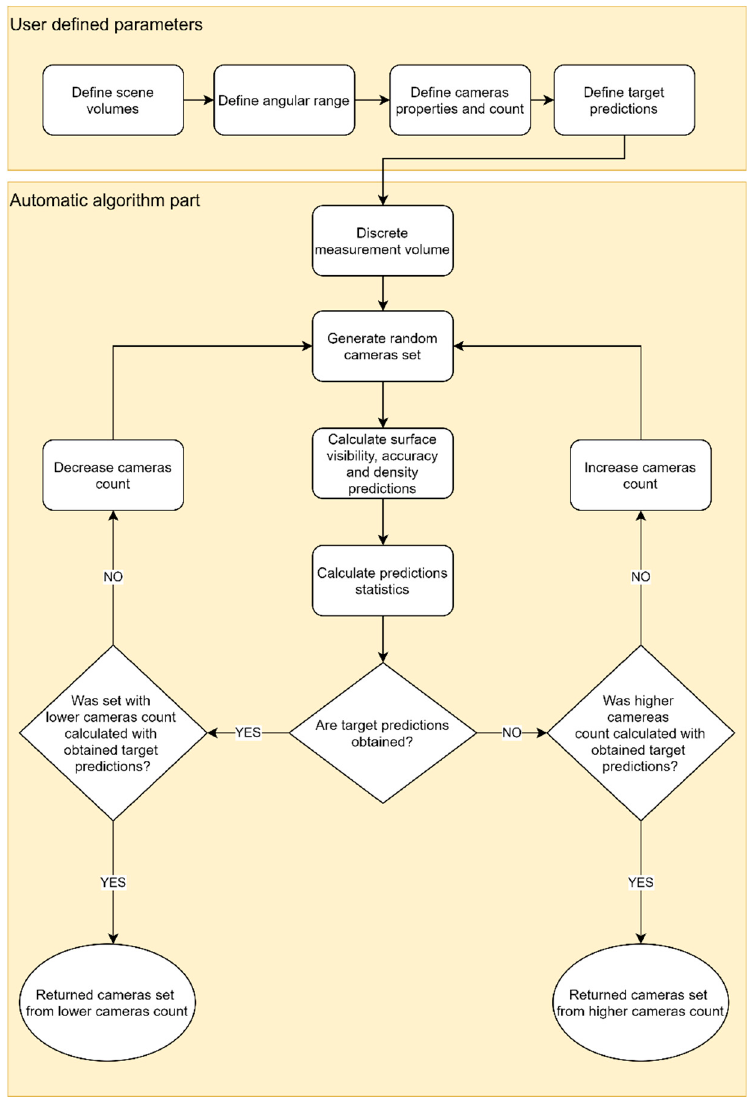
Figure 1. Scheme of the proposed views network planning